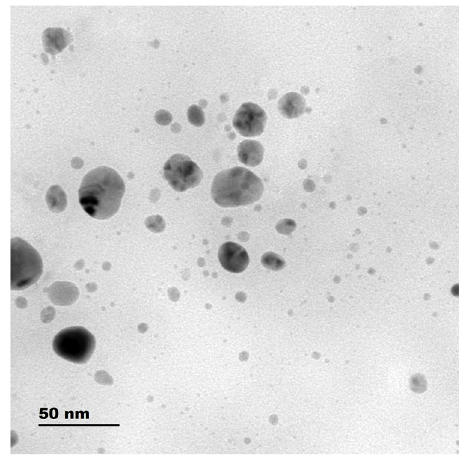
Figure 3: TEM image of Z. mays silk - fabricated